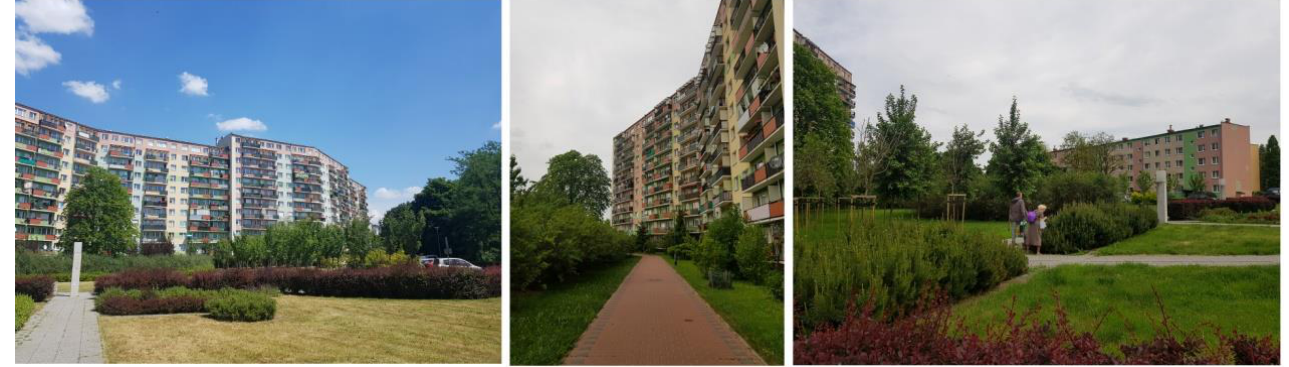
Figure 1. Several photos of the survey area, June